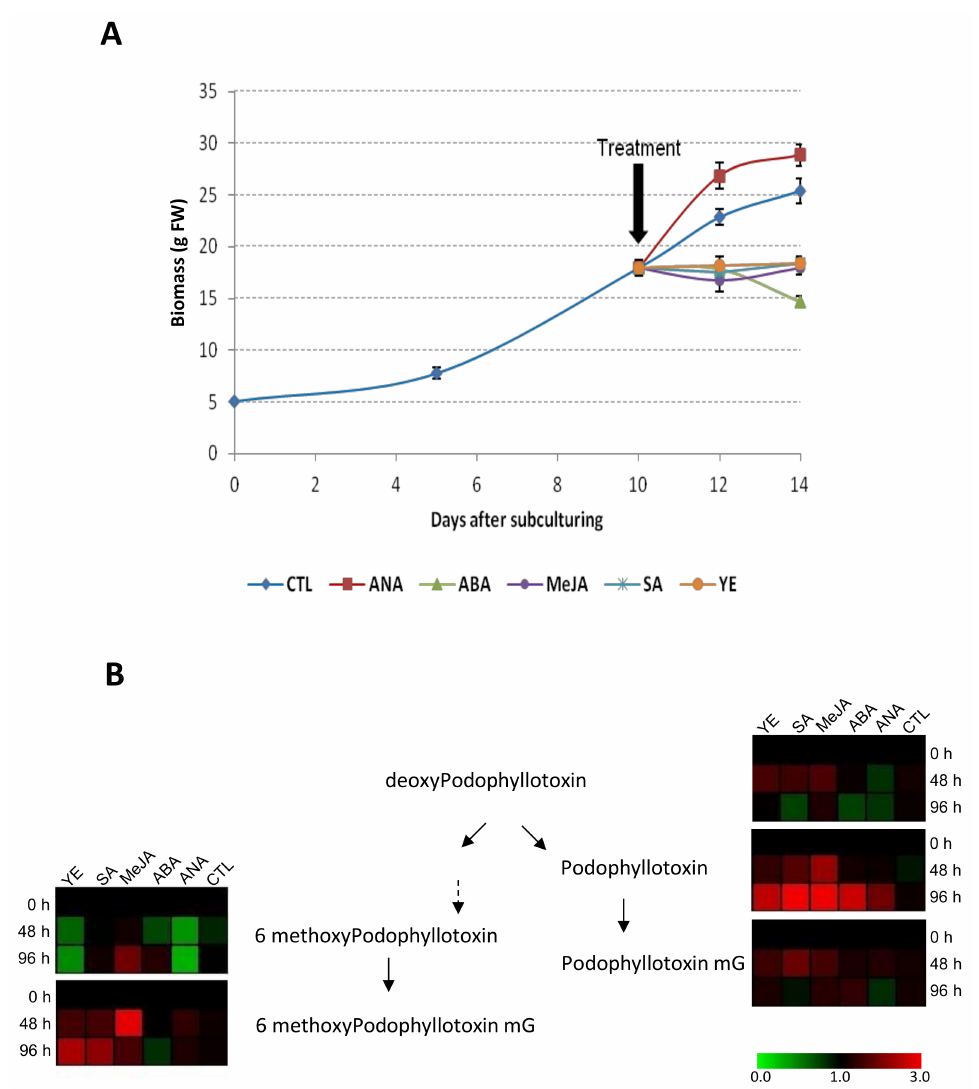
Figure 5. Impact of phytohormones and elicitors treatments on the growth and ATL accumulation profiles of HRLF15.2 line. ( A ) Growth curves of HRLF15.2 line treated with NAA (1 mg/mL), ABA (100 µ M), MeJA (100 µ M), SA (100 µ M) or YE (3% w / v ); ( B ) Relative impact of NAA (1 mg/mL), ABA (100 µ M), MeJA (100 µ M), SA (100 µ M) or YE (3% w / v ) treatments on the intracellular accumulation kinetic of the main ATL and their glucosylated forms in HRLF15.2 line. Detailed ATL accumulation kinetics are presented in Figure S3. Each point is the mean and standard deviation of the three independent